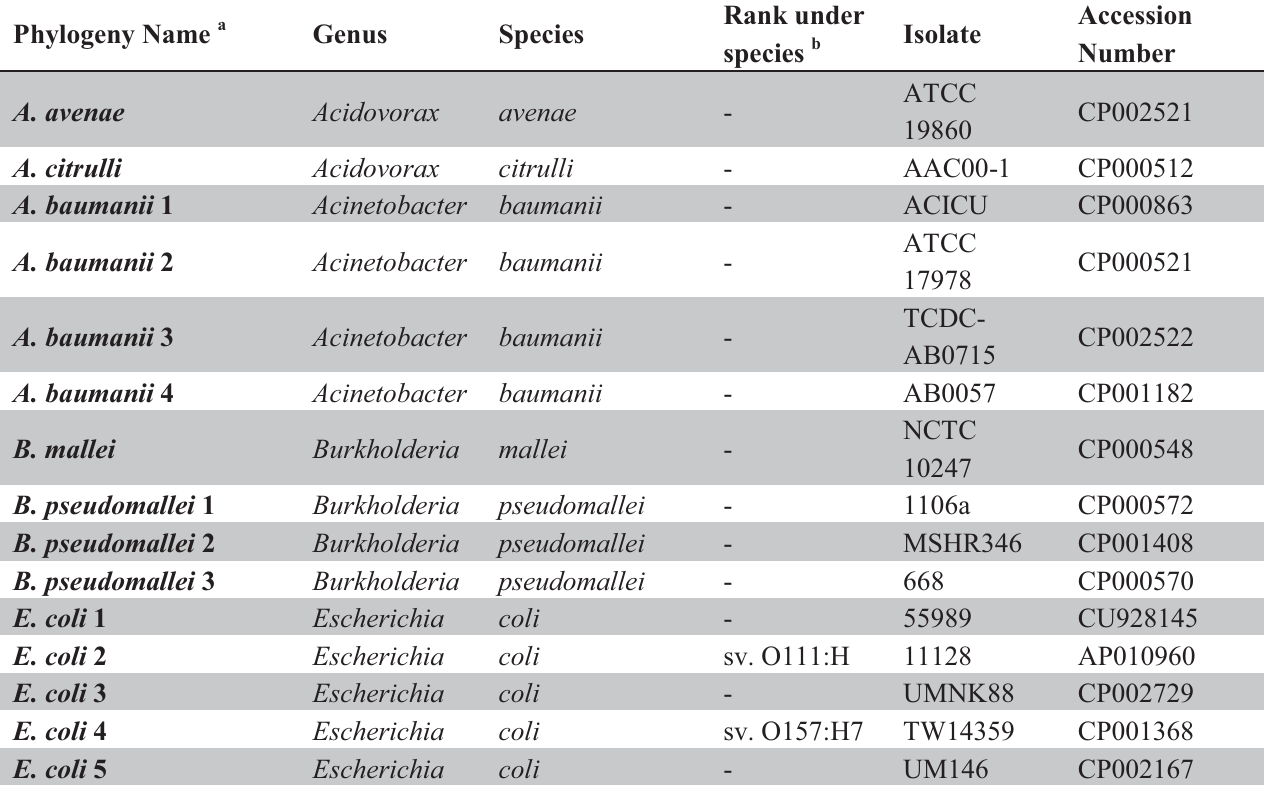
Table S1. Bacterial pathogen complete genomes from GenBank used to obtain pilA DNA sequences used in pilA phylogeny (Figure